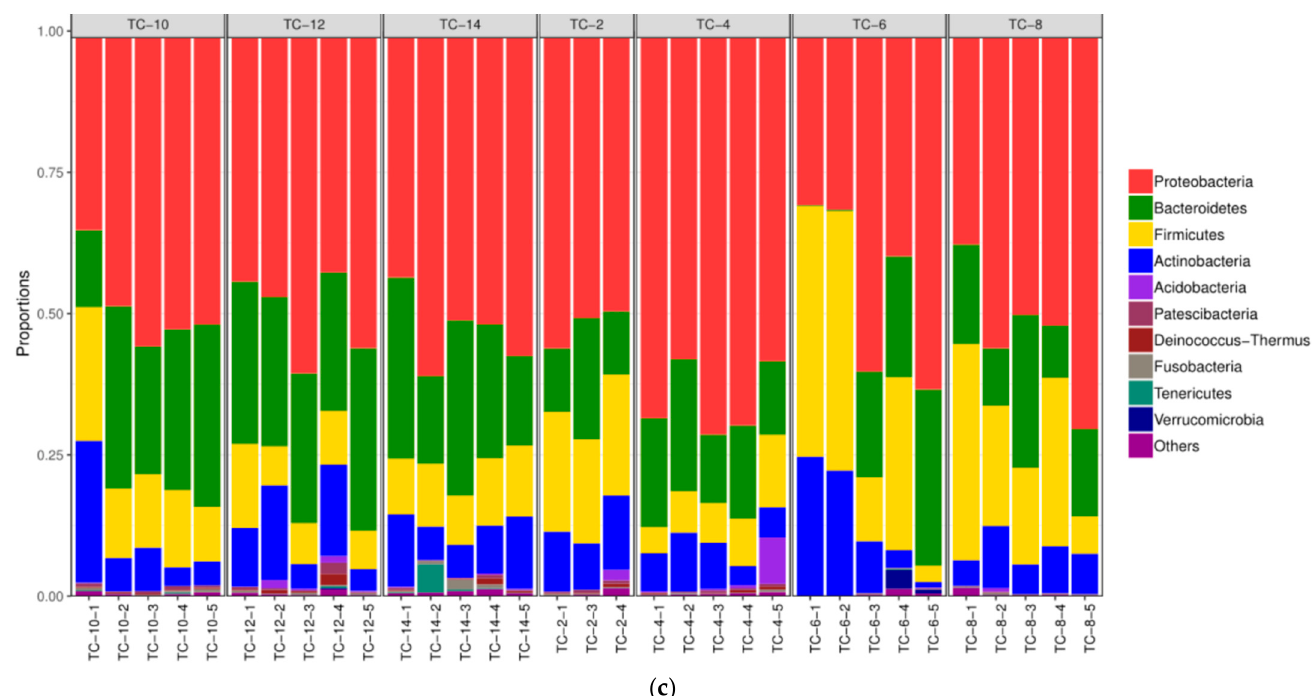
Figure 6. Community structure components of air ( a ), foreleg ( b ), and thorax ( c ) microorganisms at the phylum level.